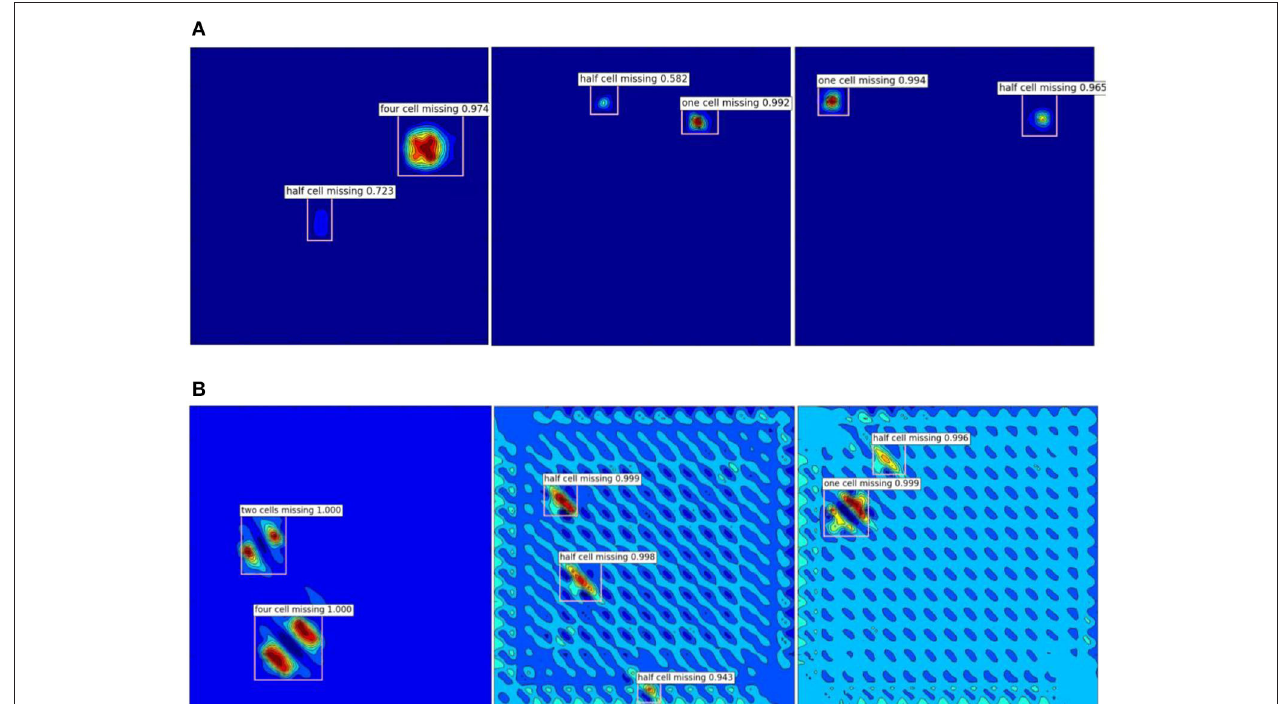
FIGURE 8 | Examples of the identified results. (A) DI-1 and (B)